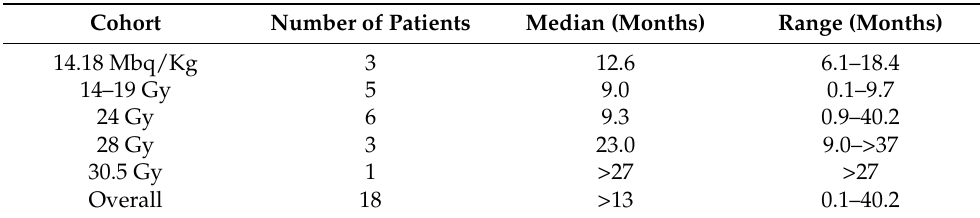
Table 3. Response rates and duration by dose